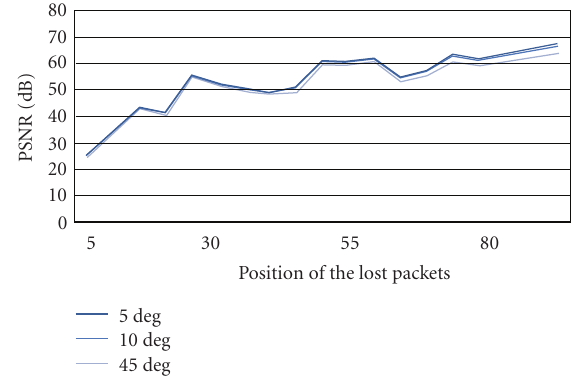
Figure 11: Goku : loss of a batch of 5 consecutive packets of texture information. The di ff erent curves correspond to the di ff erent viewpoints as shown in Figure 7. Note how the 5 ◦ curve is almost invisible because the 10 ◦ one is almost perfectly superimposed to